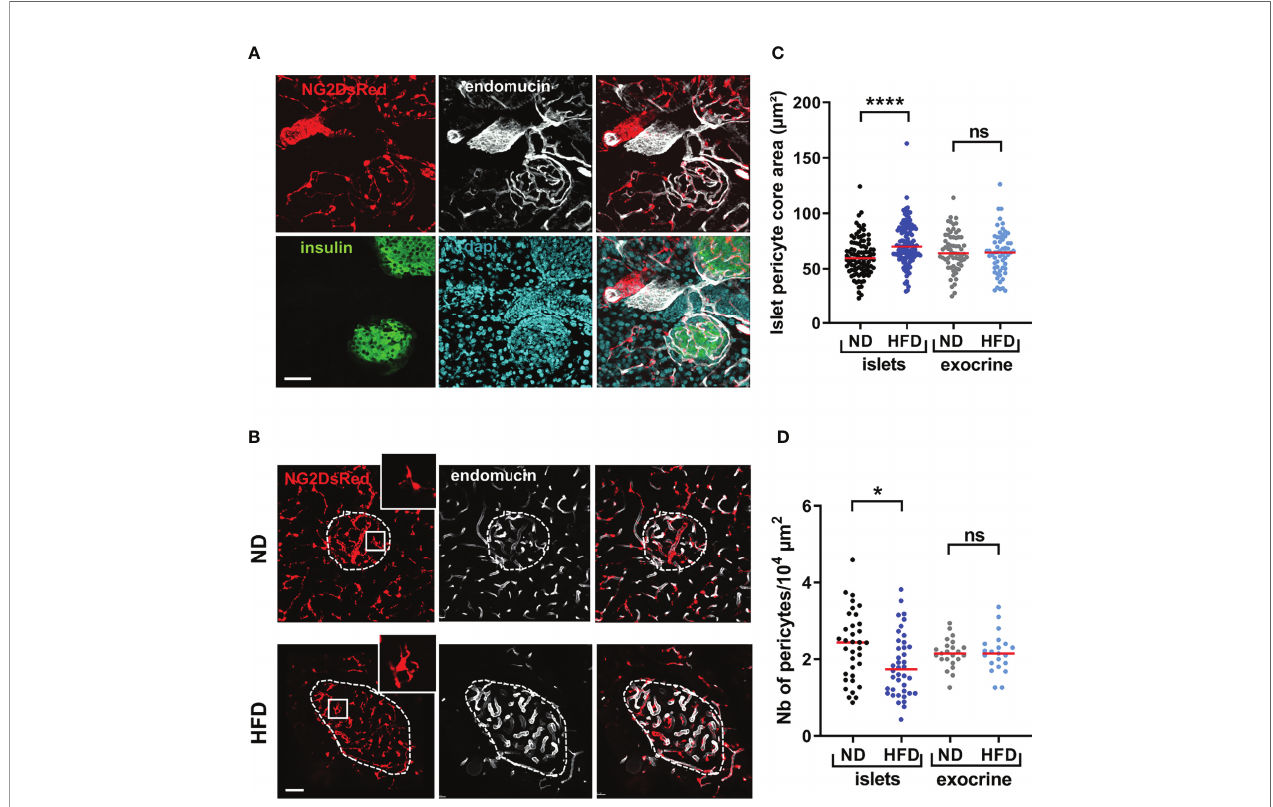
FIGURE 1 | Morphological alterations of islet pericytes following 16 weeks HFD treatment. (A) Confocal images of pancreatic islets of a NG2DsRed mouse (scale: 50 µm, 30 µm Z-projection; red: NG2DsRed, green: insulin, white: endomucin, blue: dapi), showing NG2DsRed cellular bodies and processes line capillaries. (B) Representative confocal images showing pericyte hypertrophy after HFD treatment in NG2DsRed mice (scale: 50 µm, 20 µm Z-projection; red: NG2DsRed, white: endomucin). Inlet pictures correspond to enlargements of the boxed areas on left panels. ND, normal diet; HFD, high-fat diet. (C) Quanti fi cation of pericyte core area (n= 3-5 mice/condition, mean ± SEM, One-way ANOVA). (D) Number of pericyte cellular bodies containing a nucleus on single plane images were counted and divided by islet surface or exocrine tissue surface in the image (n= 3-5 mice/condition, mean ± SEM, One-way ANOVA). *P < 0.05, ****P < 0.0001. ns, non signi fi